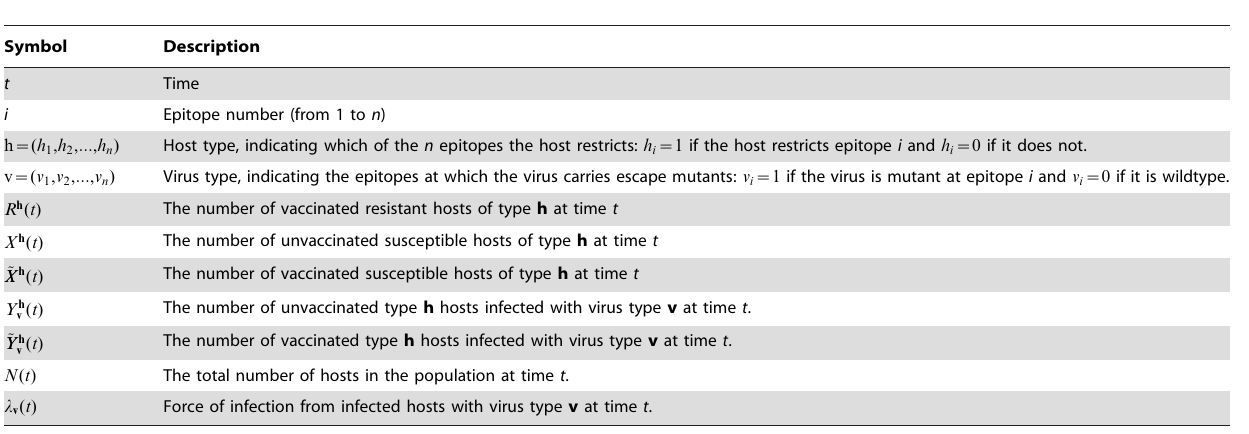
Table 1. A description of variables used to describe our